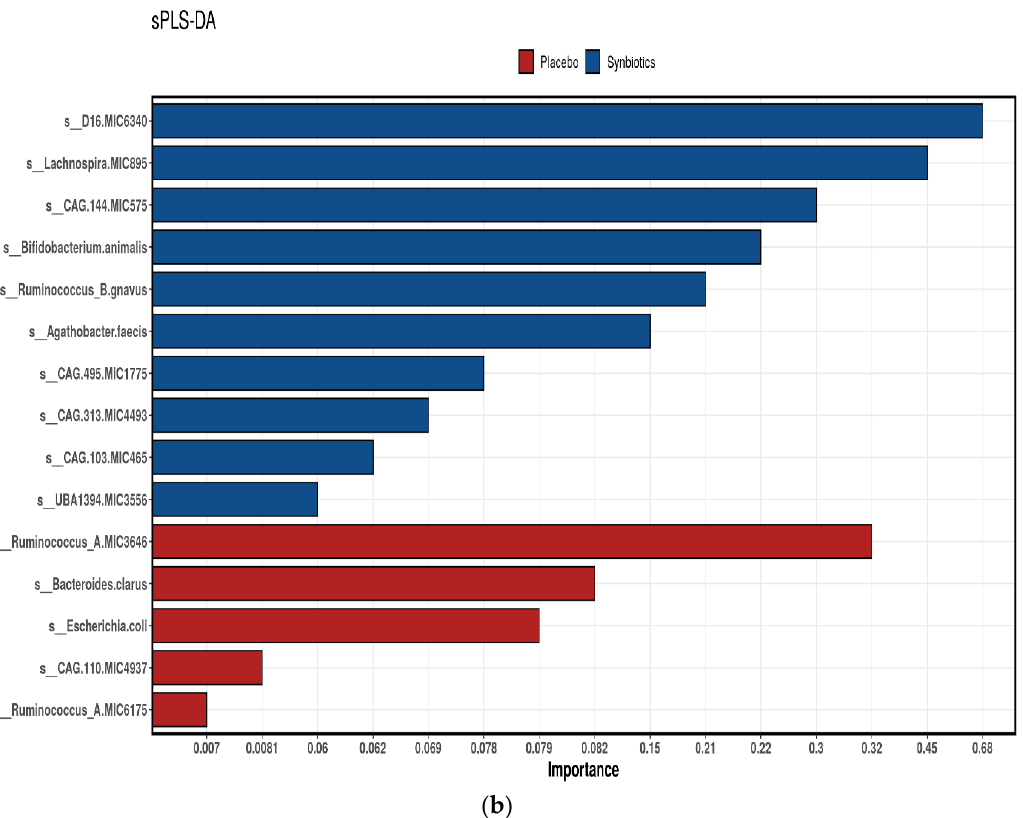
Figure 3. ( a ) sPLS-DA of gut microbiome composition by intervention. ( b ) Species differentiating between gut microbiota profiles of participants after placebo or synbiotic supplementation as identified by sparse Partial Least Squares Discriminant Analysis (sPLS-DA).